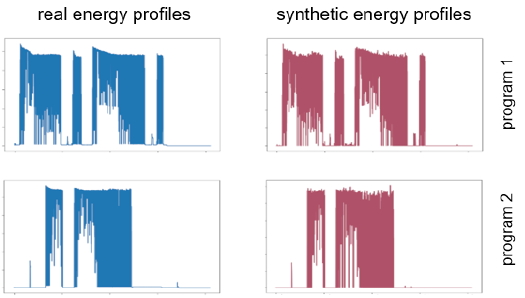
Figure 5. Comparison of two real energy consumption patterns from different programs of a Thermomix and two with a cWGAN-GP synthetically